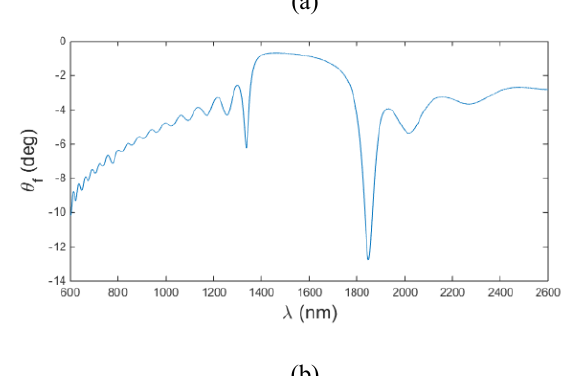
FIGURE 3. Transmittance spectra of 1D photonics crystal made with magneto-optic in different configurations. Fig.3 In the representation of the spectral transmission, curves we distinguish the existence of two photonic bandgaps. The first photonic band gap is in the visible region with a range (562 nm -585 nm) and the second is in the NIR region from 1500 nm to 1950